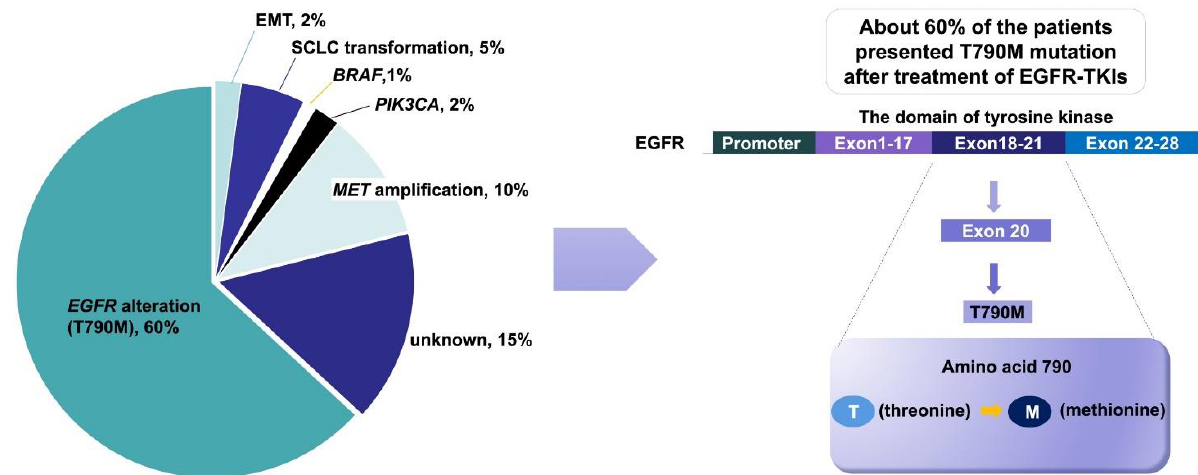
Figure 2. Mechanism and mutation frequency of acquired resistance to EGFR-TKIs. Reprinted with permission from ref. [52]. Copyright 2018 Springer